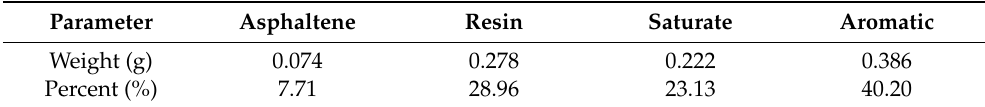
Table 2. Separation test results of PG64-16 matrix asphalt.